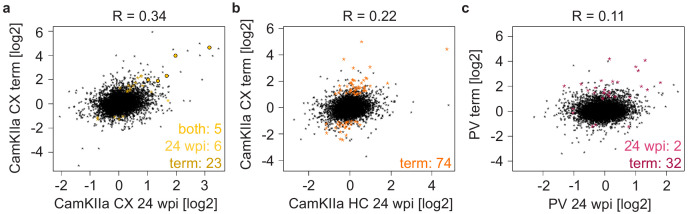
Comparison of prion-induced changes during disease progression.(a-c) Scatterplots comparing prion-induced changes at the pre-terminal (24 weeks post inoculation (wpi)) and terminal time points in CamKIIa cortical (a), and hippocampal (b) neurons and in PV neurons (c). Genes changing at one or both time points are indicated.